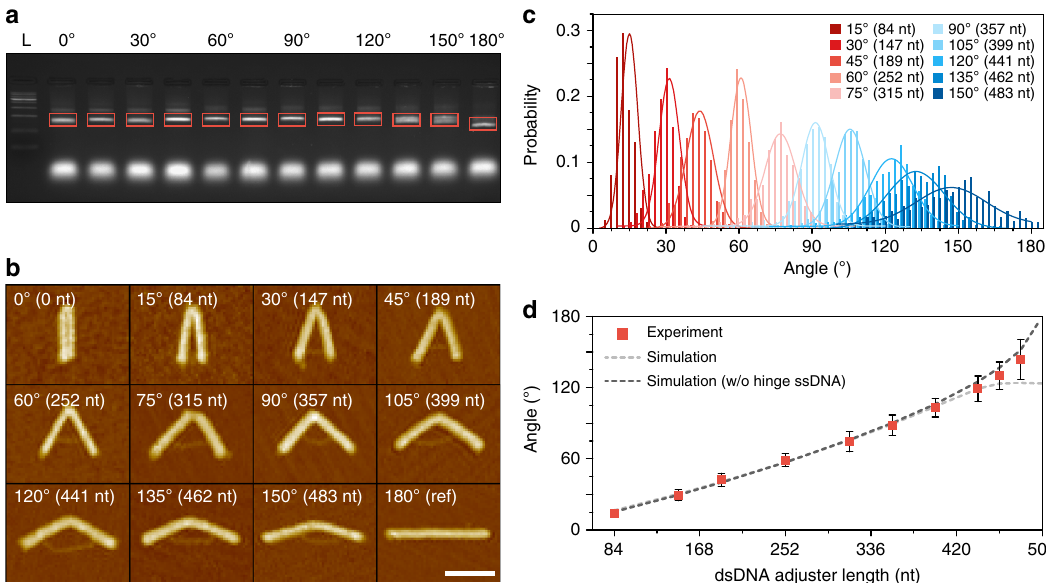
Fig. 3 Broad and precise included angle variation of the hinge structure by controlling the length of the dsDNA adjuster strand. a Agarose gel electrophoresis result of each design. Orange boxes are monomer structure bands, and the bottom bands are excessive staples. L: 1 kb DNA ladder. b Representative AFM images of each structure. Large-area AFM images of each structure were shown in Supplementary Figs. 6, 21 and 22. Scale bar: 100 nm. c Histograms of included angle distribution of each structure. Solid lines indicate the Gaussian distribution. See Supplementary Table 5 for detailed results. d Measured average included angle and CanDo analysis result. Error bars indicate standard deviation of experimental data. See